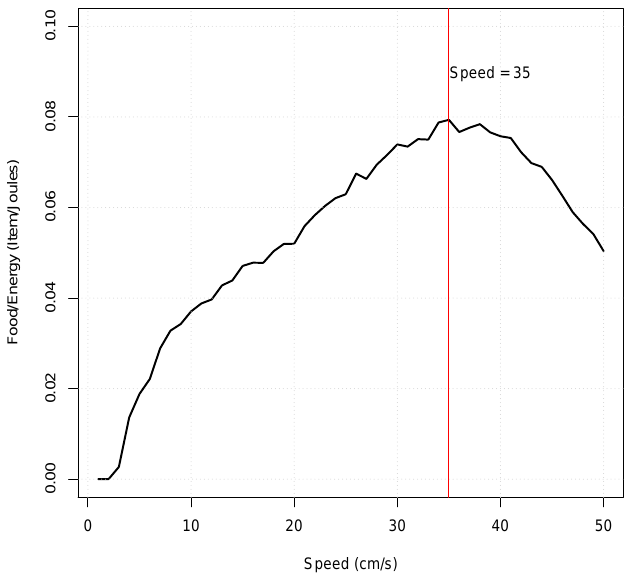
Figure 3. Graph showing average food gathered per energy unit consumed in a swarm of 20 foraging robots across 50